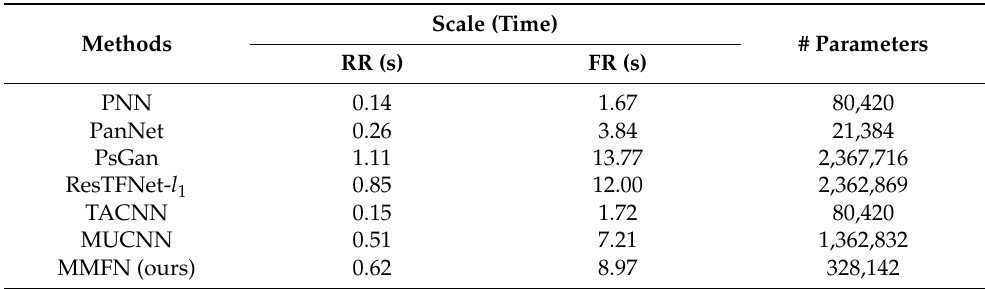
Table 5. Parameter numbers and running times for the compared deep learning methods on datasets at different